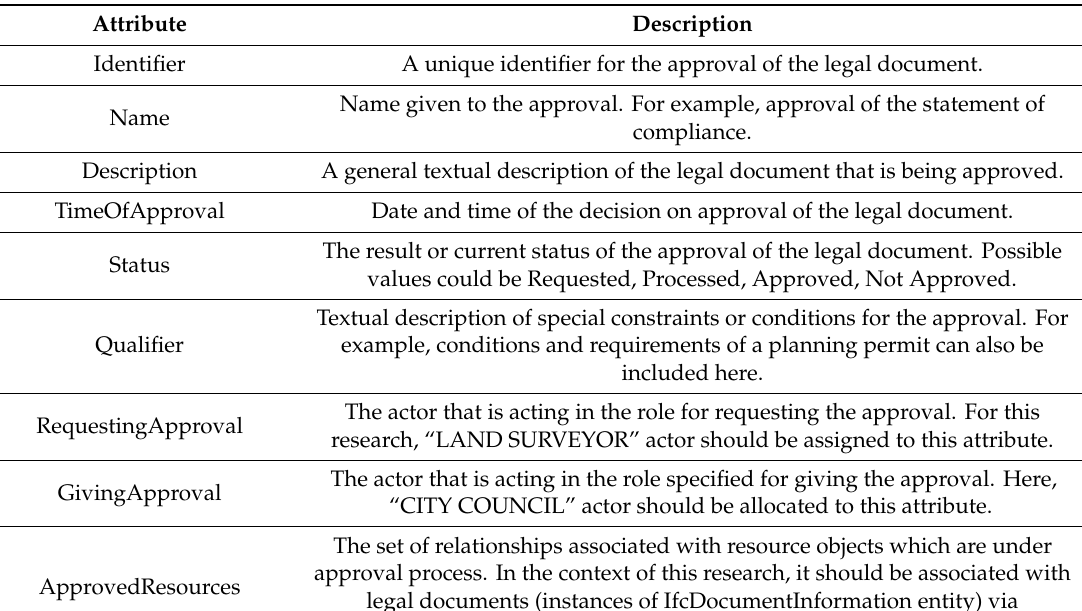
Table 3. Attributes used for approval of legal documents (extracted from [46]).